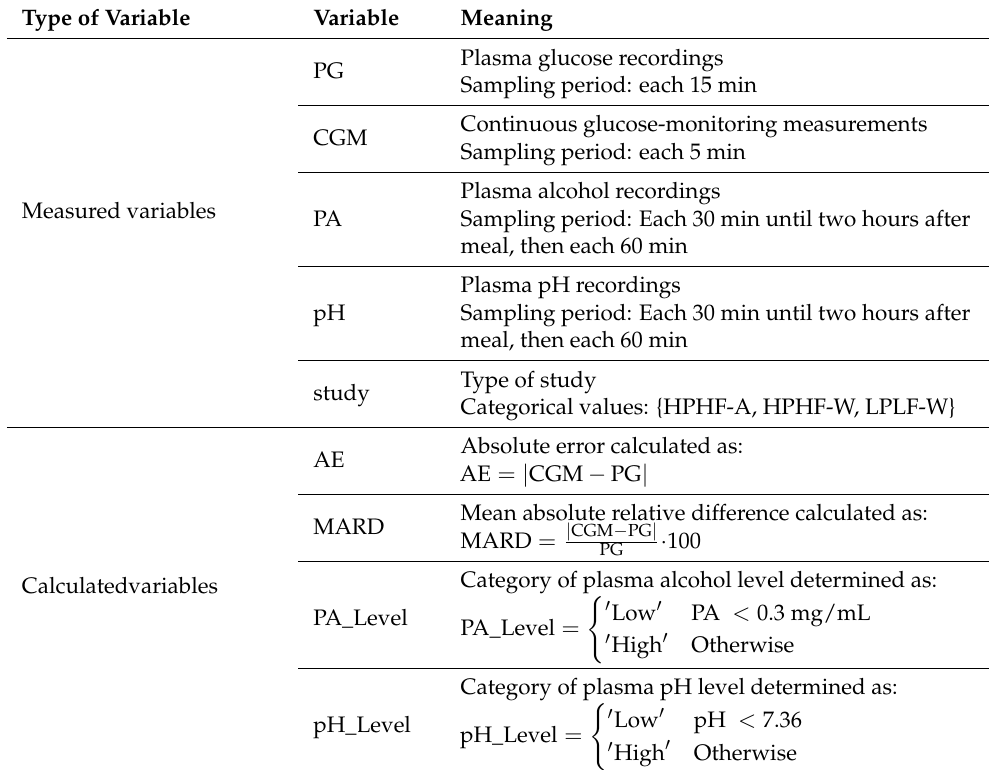
Table 1. Set of variables used for assessing the effect of the alcohol on the sensor accuracy. Type of